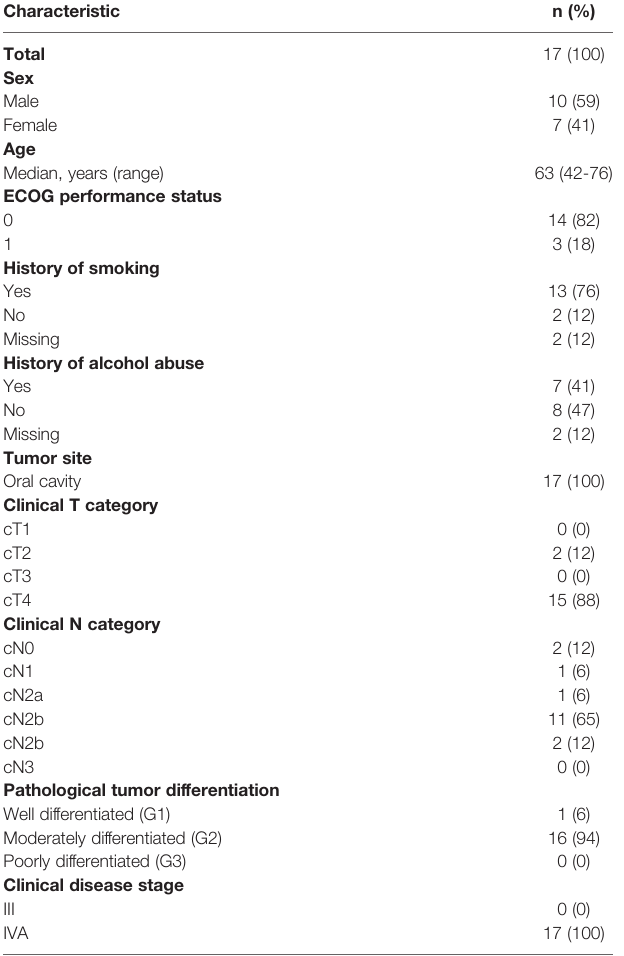
TABLE 1 | Baseline characteristics. Clinical disease stage according to UICC TNM classi fi cation (8 th edition); ECOG, Eastern Cooperative Oncology Group. Characteristic